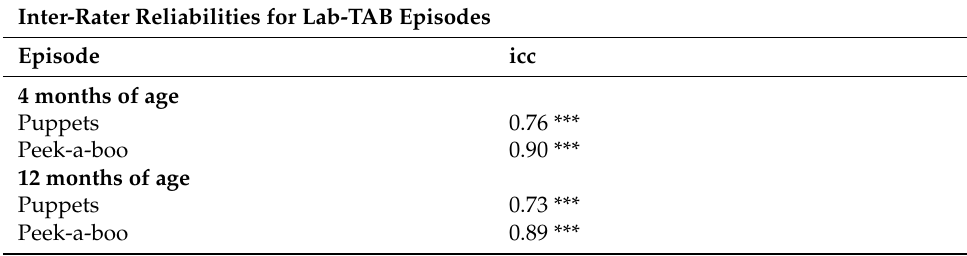
Table A1. Inter-Rater Reliabilities for Lab-TAB